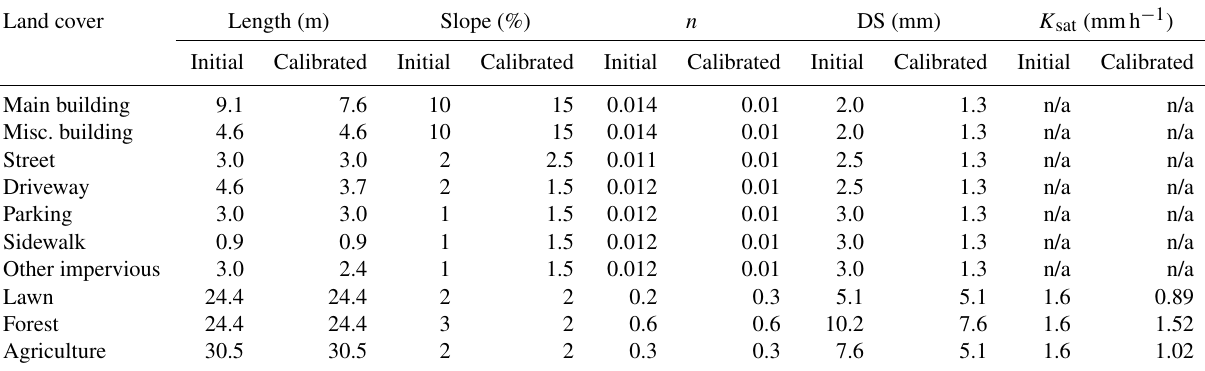
Table 1. Initial and calibrated modeling parameters for the Shayler Crossing watershed. “n/a” indicates the parameter is not applicable to the land cover type.